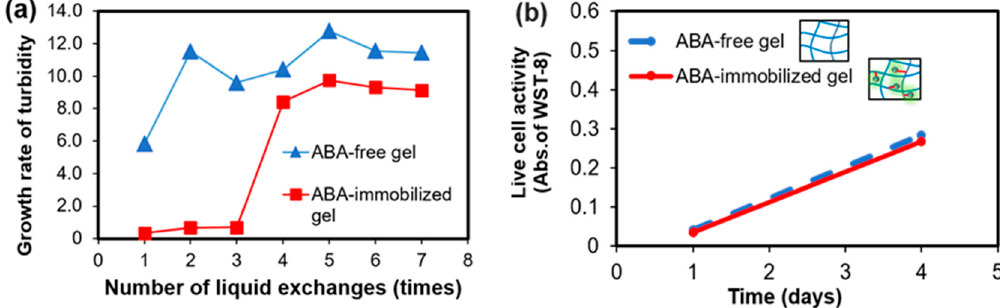
Figure 5. ABA-free gelatin gel and ABA-immobilized gelatin gel: ( a ) Turbidity increase rate with respect to the number of liquid changes and ( b ) evaluation of the number of viable cells in the human umbilical vein endothelial cells (HUVEC) culture on the gels.